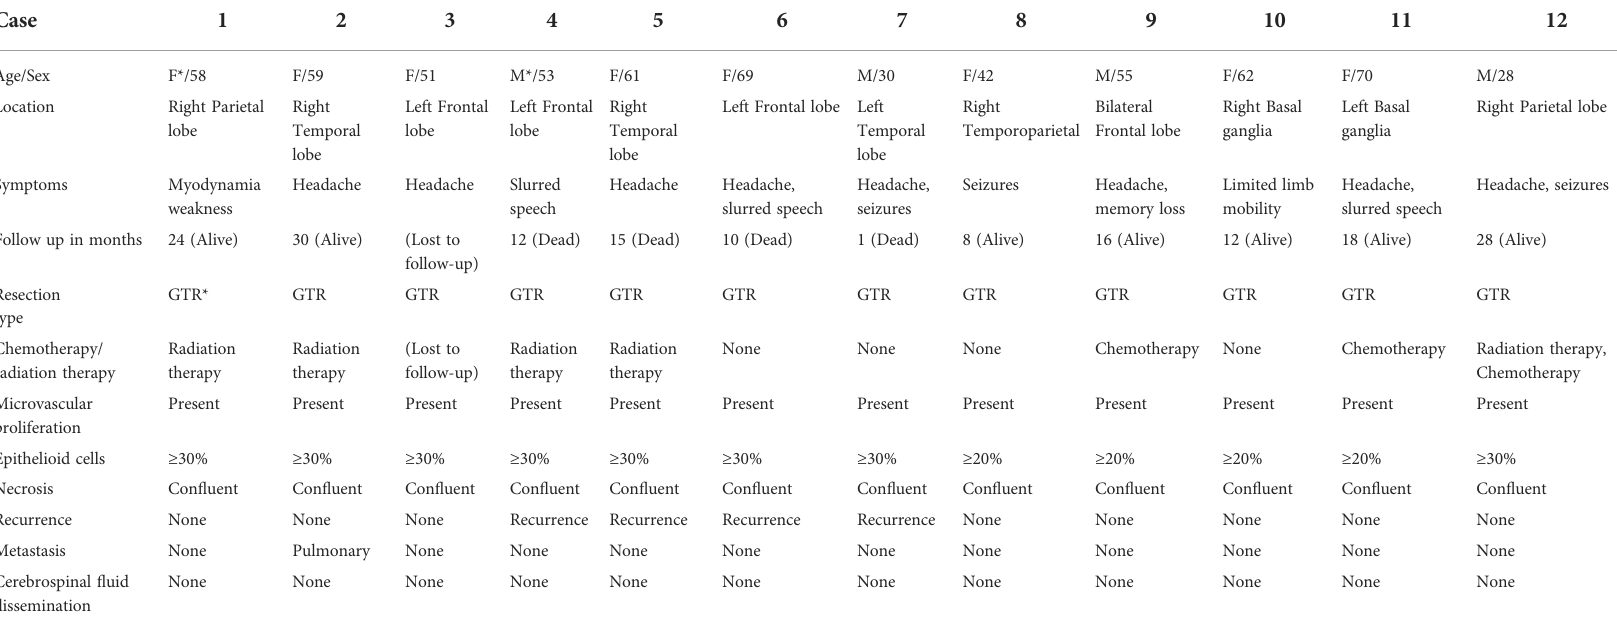
TABLE 1 Summary of the clinical parameters of 12 eGBM